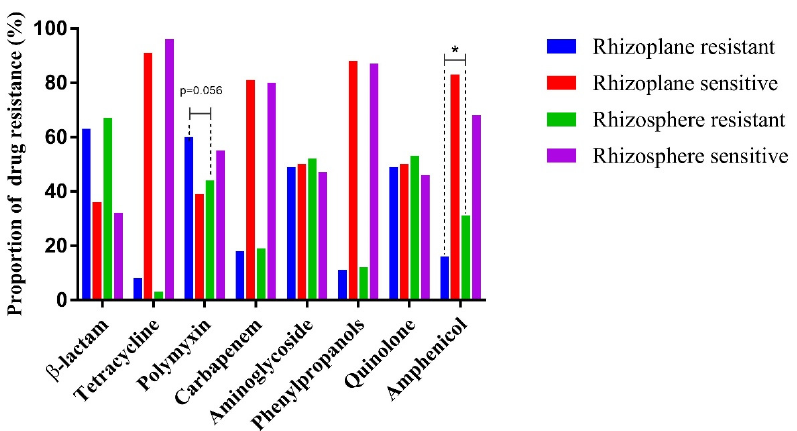
Figure 3. Antibiotic resistance profile differences between the rhizosphere and rhizoplane isolates. The prevalence difference of polymyxin and amphenicol-resistant isolates from the rhizosphere and rhizoplane was shown in the figure. Fisher exact test was used for antibiotic resistance profile comparison between the rhizosphere and rhizoplane isolates, and * denoted p < 0.05.